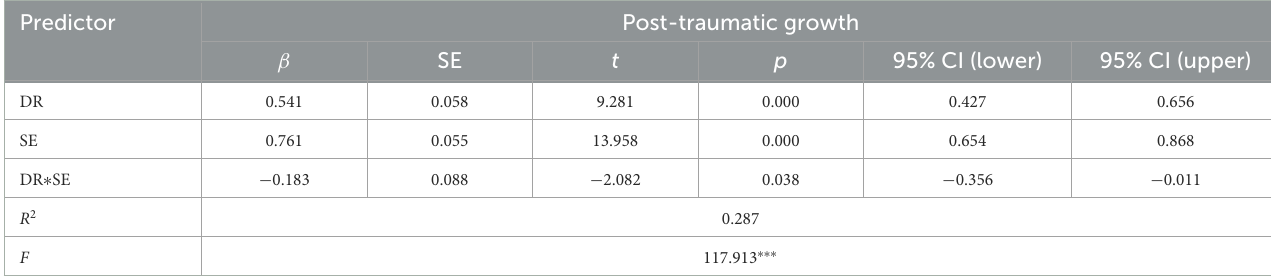
TABLE 3 Moderated mediating effect of general self-efficacy on post-traumatic growth.